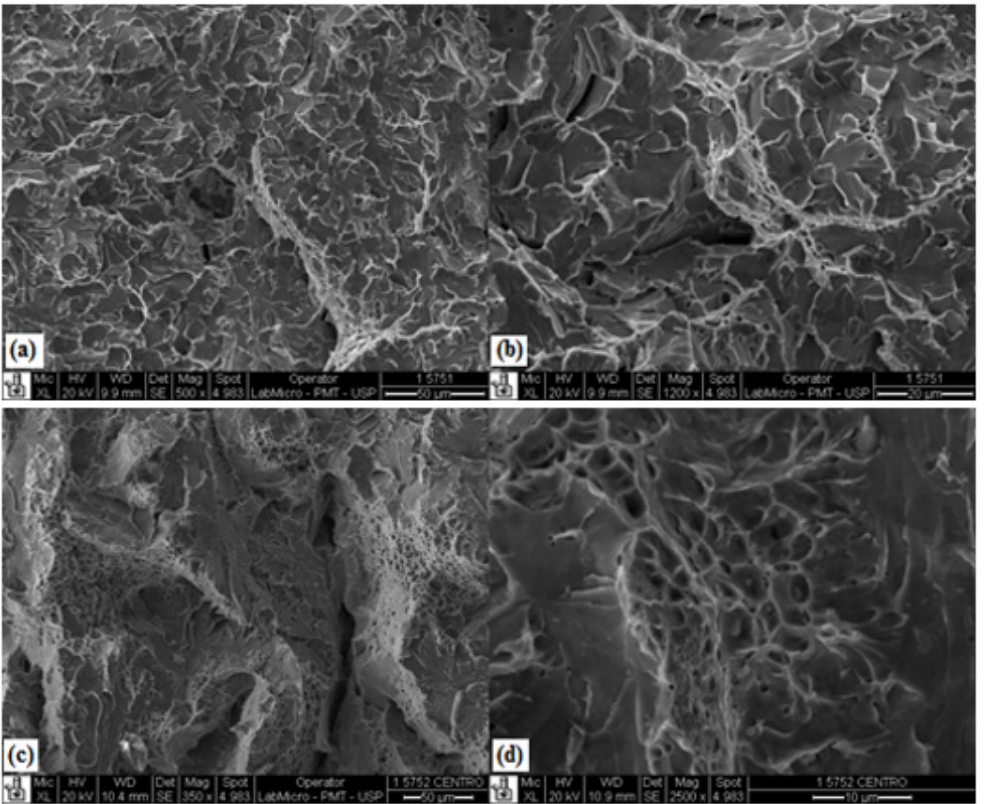
Figure 17: (a) and (b) SEM fractographs of Charpy samples at 0°C of the weld metal for S-SAW; (c) and (d) SEM fractographs of Charpy fractographs at 0°C of the weld metal for